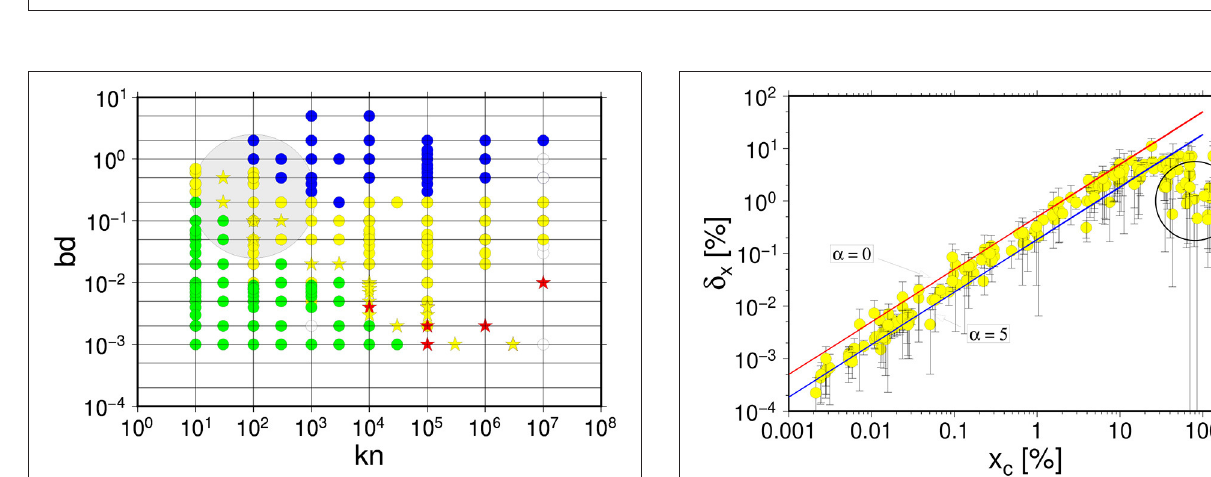
FIGURE 14 | Snapshots (at indicated deformations x ) of the microscopic state of a sample undergoing a semi-ductile breaking process. The corresponding loading curves are shown in right panel in Figure 13 . The most essential features for this class of processes are: (a) the development and propagation of acoustic waves (upper row) and (b) multi-crack fracturing pattern (lower row). The first visible signature of development of the fracture system, appearing at about 60% strain is marked by a circle in the lower left panel and at 80% strain the sample is still far away from breaking apart. Such a slow failure process is typical for this class of processes and differentiates it from hyper-elastic ones (see Figure 12 ). The particle-particle interaction parameters for this case read: k n = 10 2 N/mm, b d = 0.6 mm.